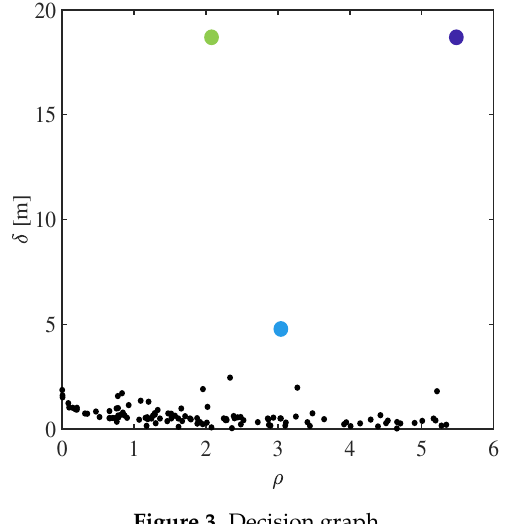
Figure 3. Decision